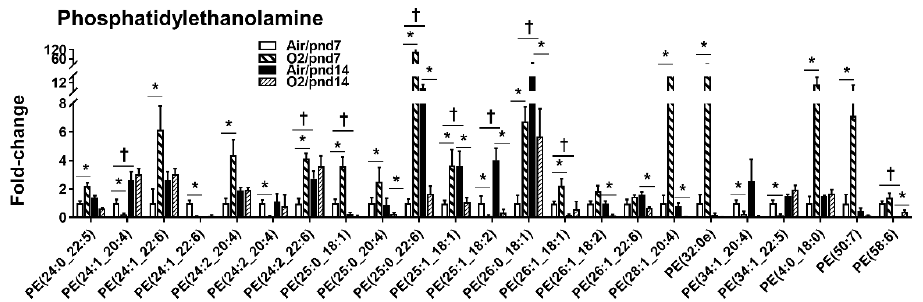
Figure 4. Compositional changes of lung PE species in mice exposed to hyperoxia as neonates. PE species in mouse lungs with 2-fold change and p < 0.05 between air and hyperoxia groups at pnd7 and pnd14 were listed. n = 6. * p < 0.05 vs. corresponding air; † p < 0.05 vs. air/pnd7 .